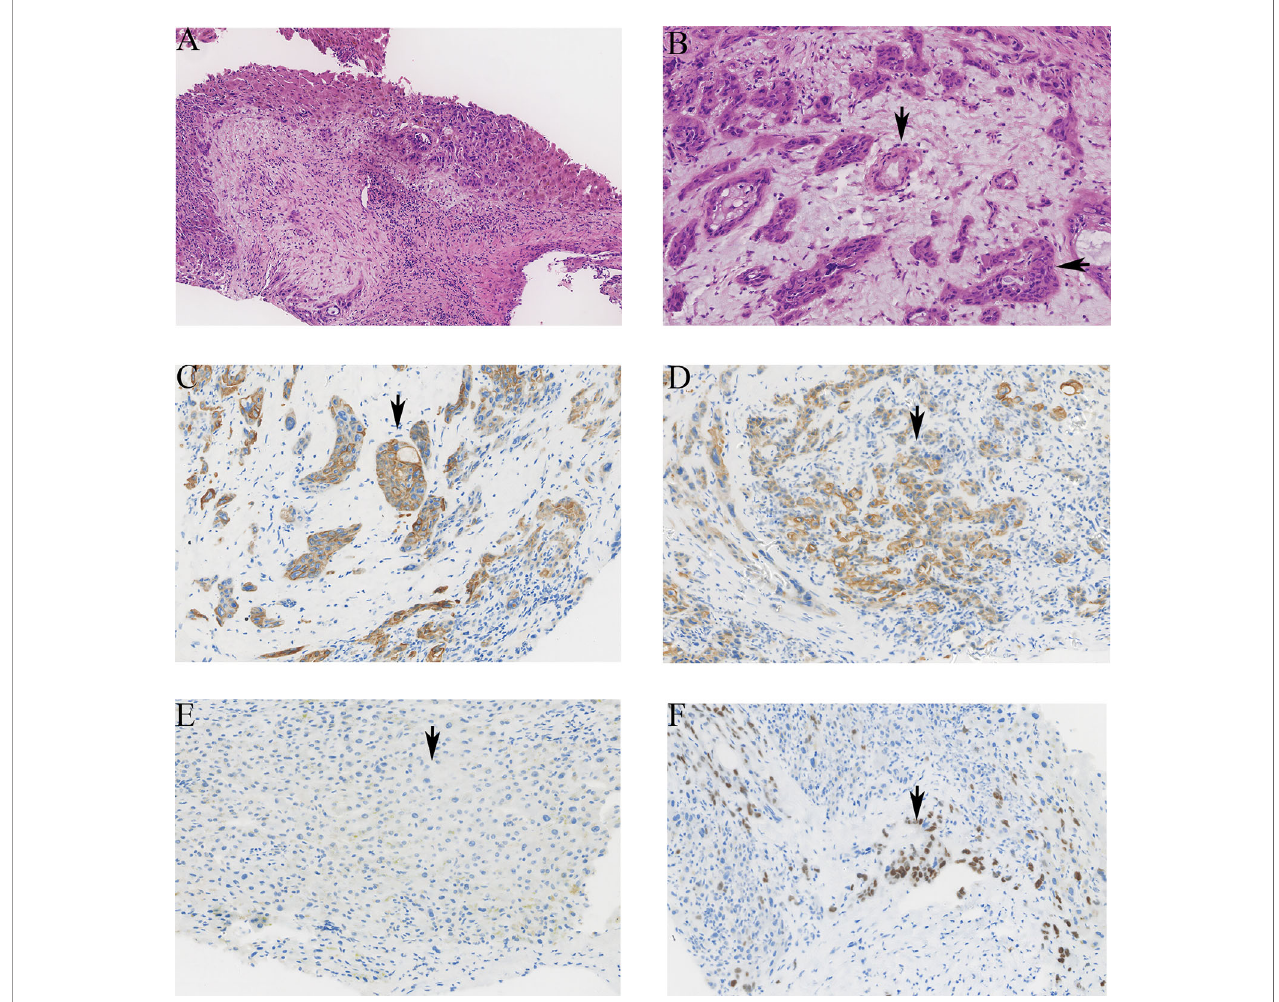
FIGURE 2 | The pathological images of ASC in liver. (A) The tumor showed atypia, mitosis, solid nest, and tubular structure (hematoxylin and eosin stain HE ×100). (B) The tubular structure of the tumor is the adenocarcinoma component (vertical arrow), and the cell is nest-like, which is the squamous cell carcinoma component (horizontal arrow). (C) The positive staining of CK7 was brown granular in cytoplasm (×200). (D) The positive staining of CK19 was brown granular in cytoplasm (×200). (E) The negative staining of CK20 in tumor cells (×200). (F) The positive staining of p63 was brown granular in nucleus